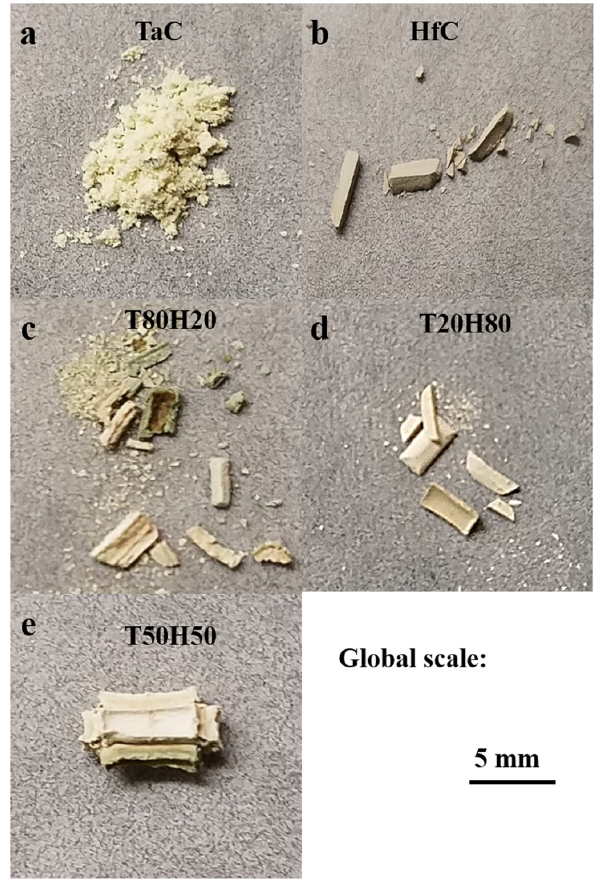
Figure 2. Post ‐ oxidation samples: ( a ) Pure TaC; ( b ) Pure HfC; ( c ) T80H20; ( d ) T20H80; and ( e ) T50H50.